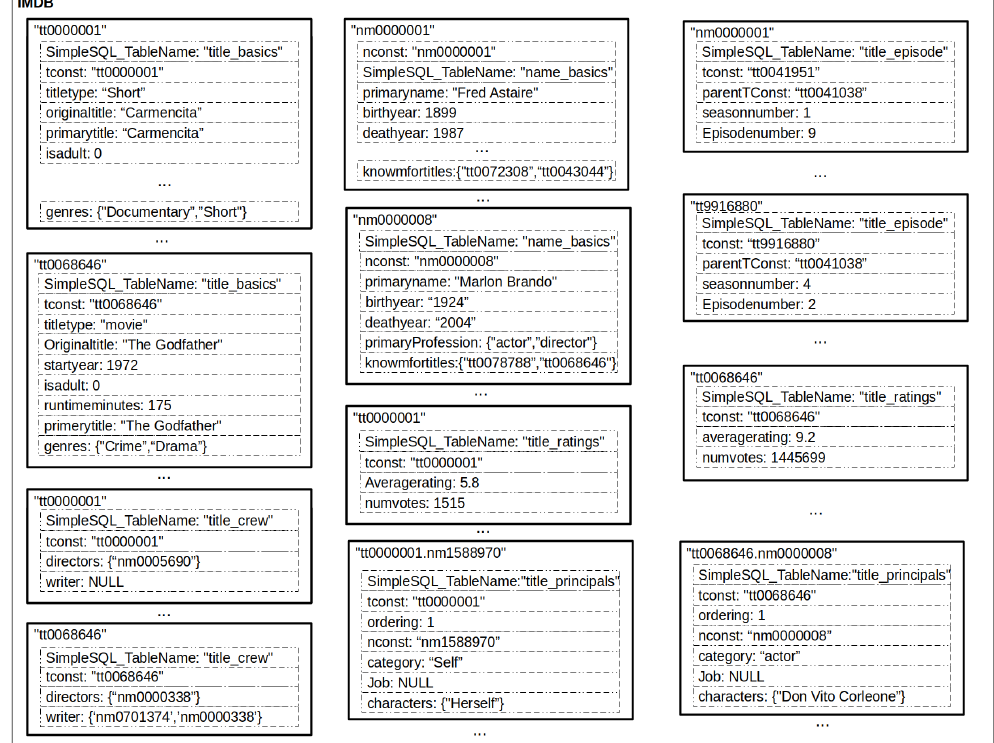
Figure 3. IMDb mapped to SimlpeSQL